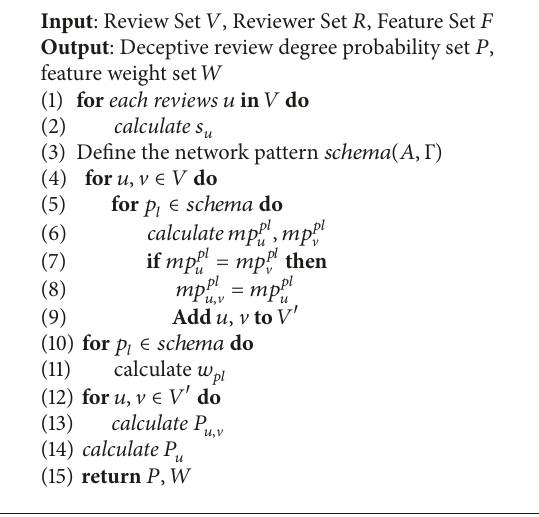
Algorithm 3: TM - DRD (𝑉,𝑅,𝐹) .